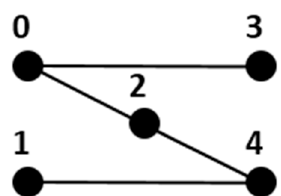
Figure 6. A 3-partite set intersection graph. Singleton vertices that represent a , b , c , d , and e comprise one partite set. Subset vertices that represent { a , b , d }, { a , d , e }, and { d , c } comprise a second partite set. A third partite set consists of subset vertices that represent { b , e } and { b , c }.